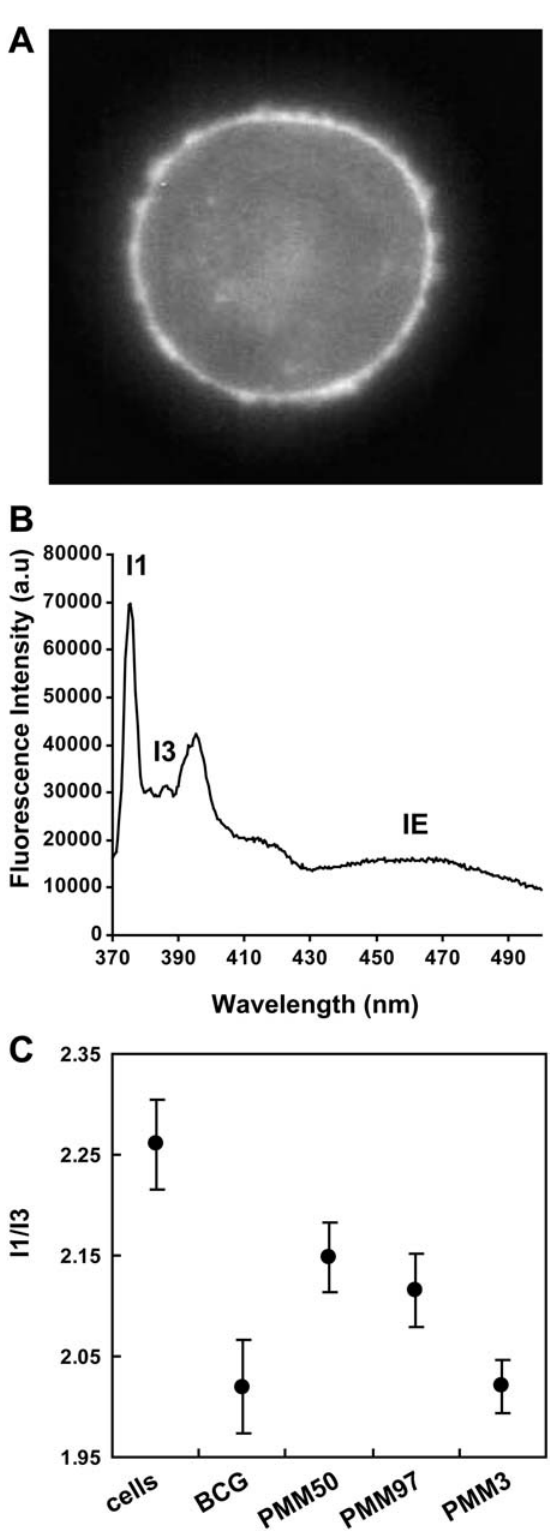
Figure 7. DIM contributes to the decrease in membrane polarity of THP-1 during the interaction with M.bovis BCG. (A) Py-met-chol was incorporated into the plasma membrane of THP-1, and cells were examined (A) by microscopy on a Zeiss Axioplan II using a DAPI Filter or (B) by spectrofluorimetry. (C) The I 1 / I 3 fluorescence ratios were determined in THP-1 cells alone (n=25) or after incubation of